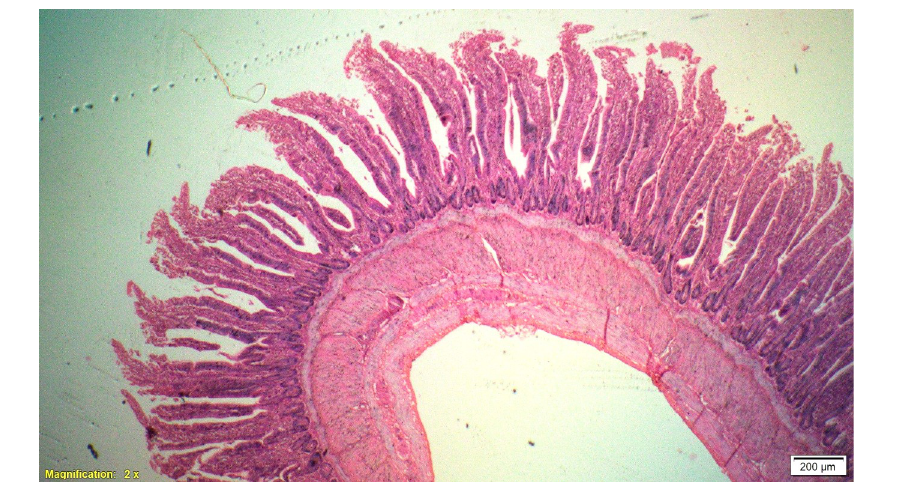
Fig 8. Photomicrograph of the cross section of ileum from antibiotic group (T2). H&E, 2x.